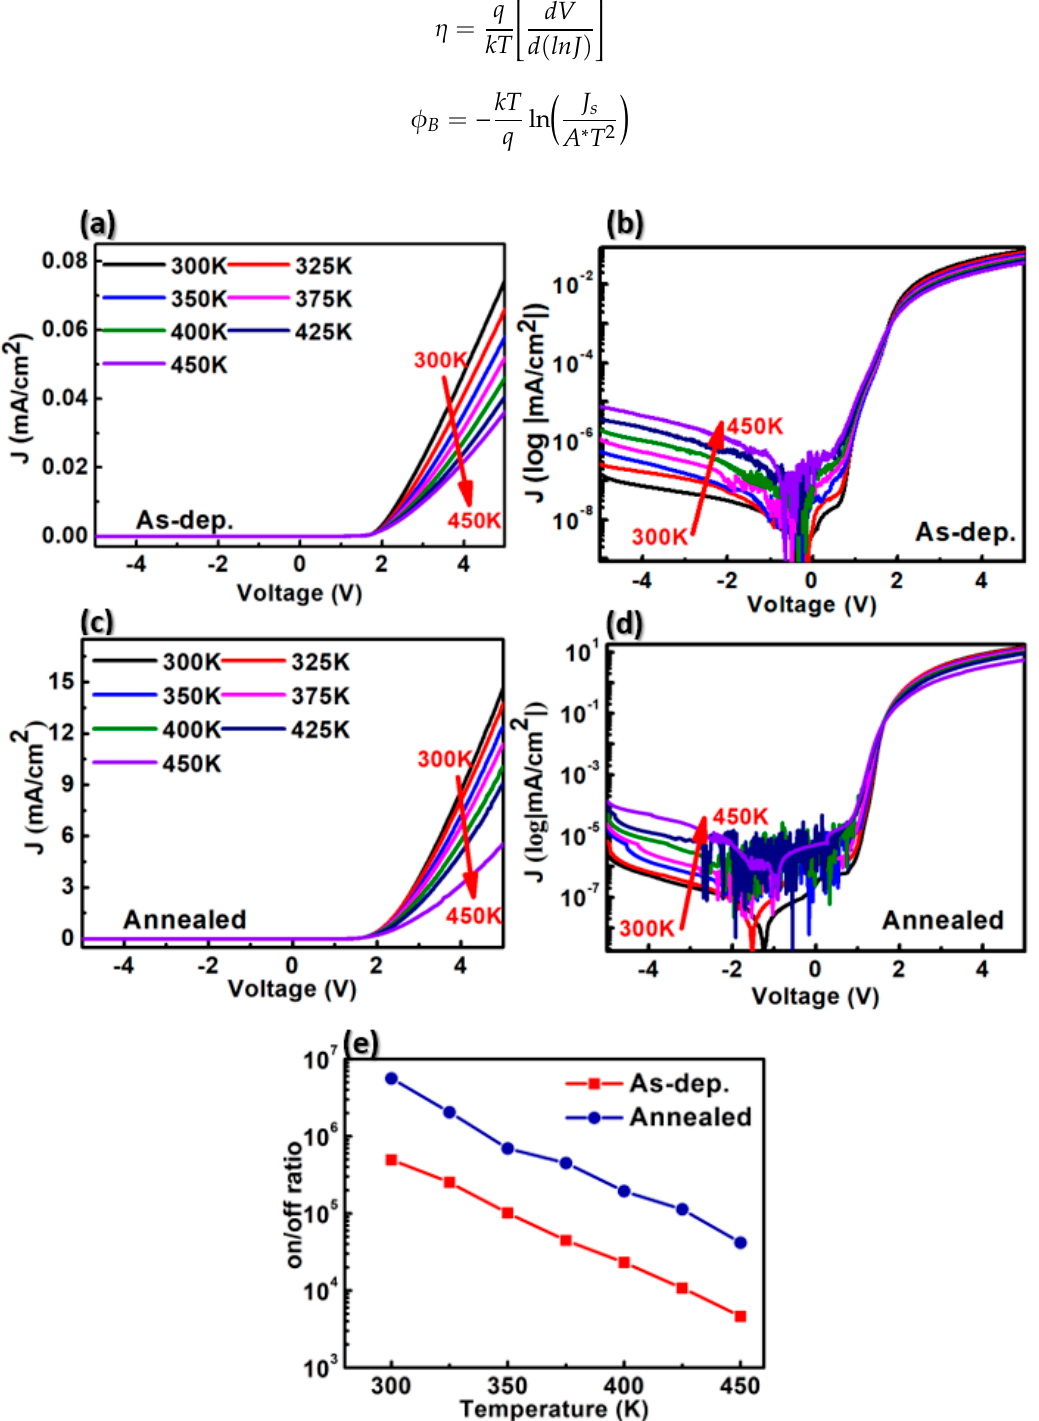
Figure 3. Temperature-dependent J-V curves of as-deposited Schottky barrier diode (SBD) ( a ) linear scale, ( b ) log scale and annealed SBD ( c ) linear scale, ( d ) log scale, ( e ) on/off ratio of fabricated SBDs.